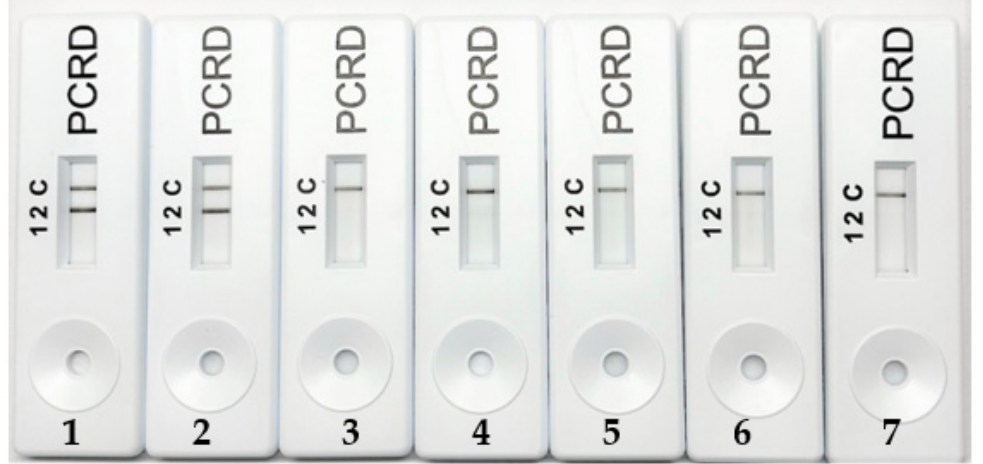
Figure 6. Analysis of RPA NALFIA on meatballs samples; (1: pork meatball brand A, 2: pork meatball brand B, 3: beef meatball brand C, 4: beef meatball brand D, 5: chicken meatball brand E, 6: chicken meatball brand F; 7: no template control).